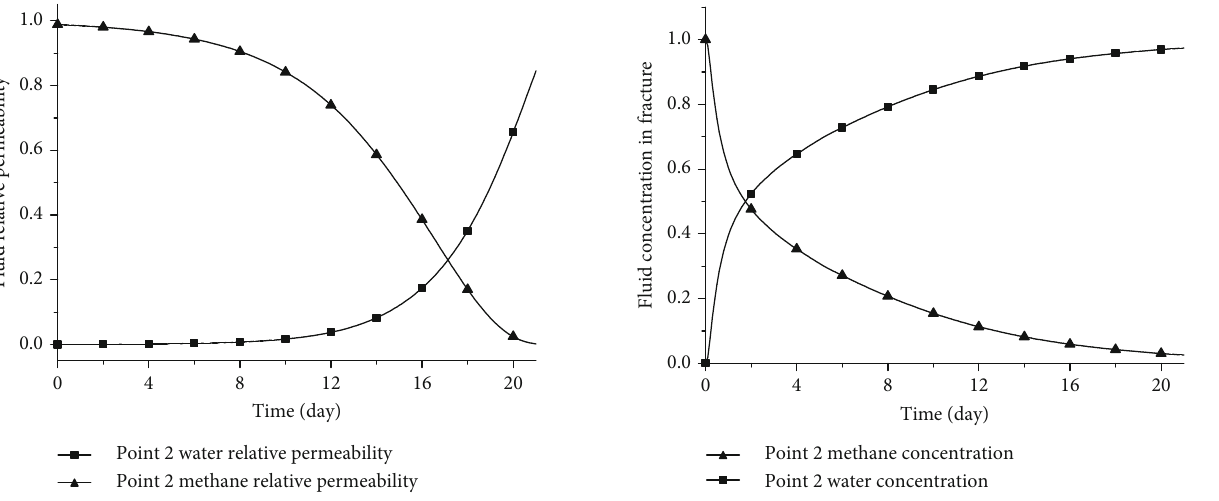
Figure 11: Fluid concentration in coal